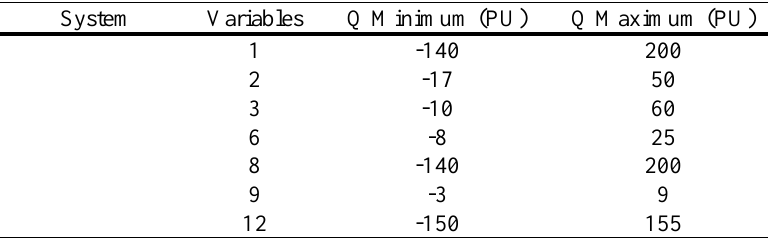
Table 8. Constrains of reactive power generators.